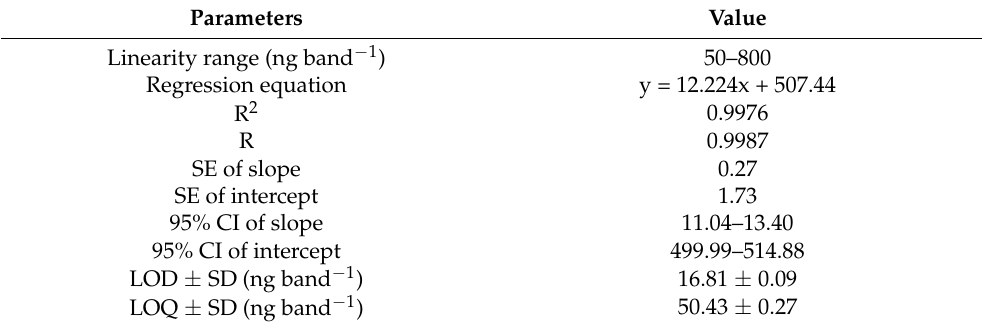
Table 2. Findings for the linearity of CIN for the present approach (mean ± SD; n = 6).